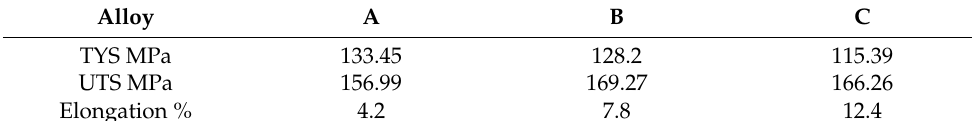
Table 1. Mechanical properties of alloys under different tensile conditions. Alloy